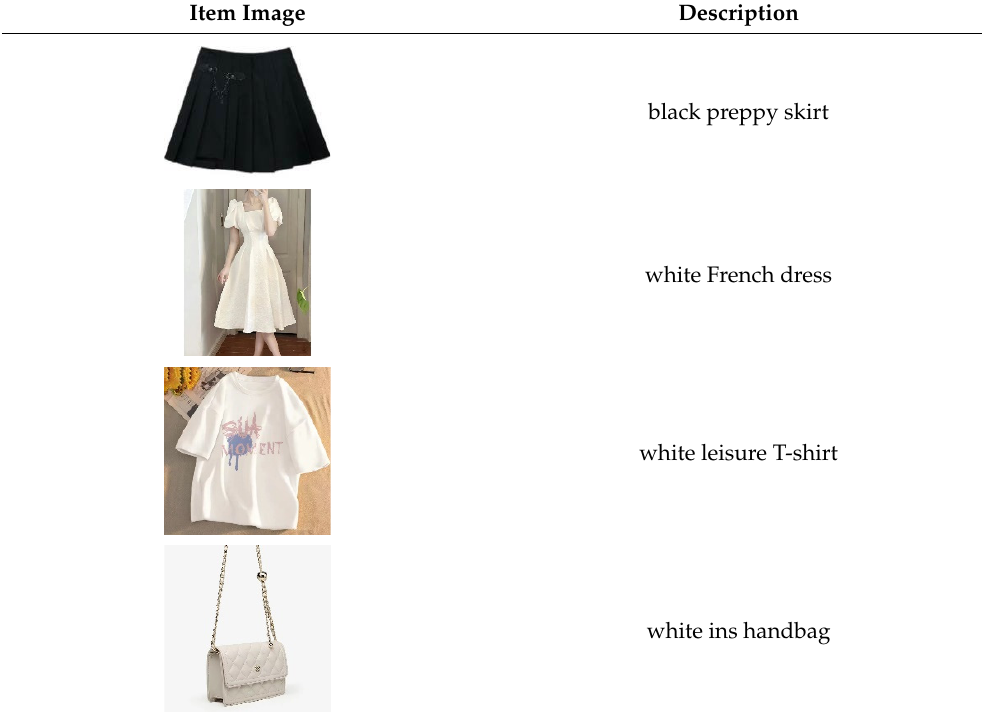
Table 1. Dimension description of item Table 1. Dimension description of item image. Table 1. Dimension description of item image. Table 1. Dimension description of item image. Table 1. Dimension description of item image.